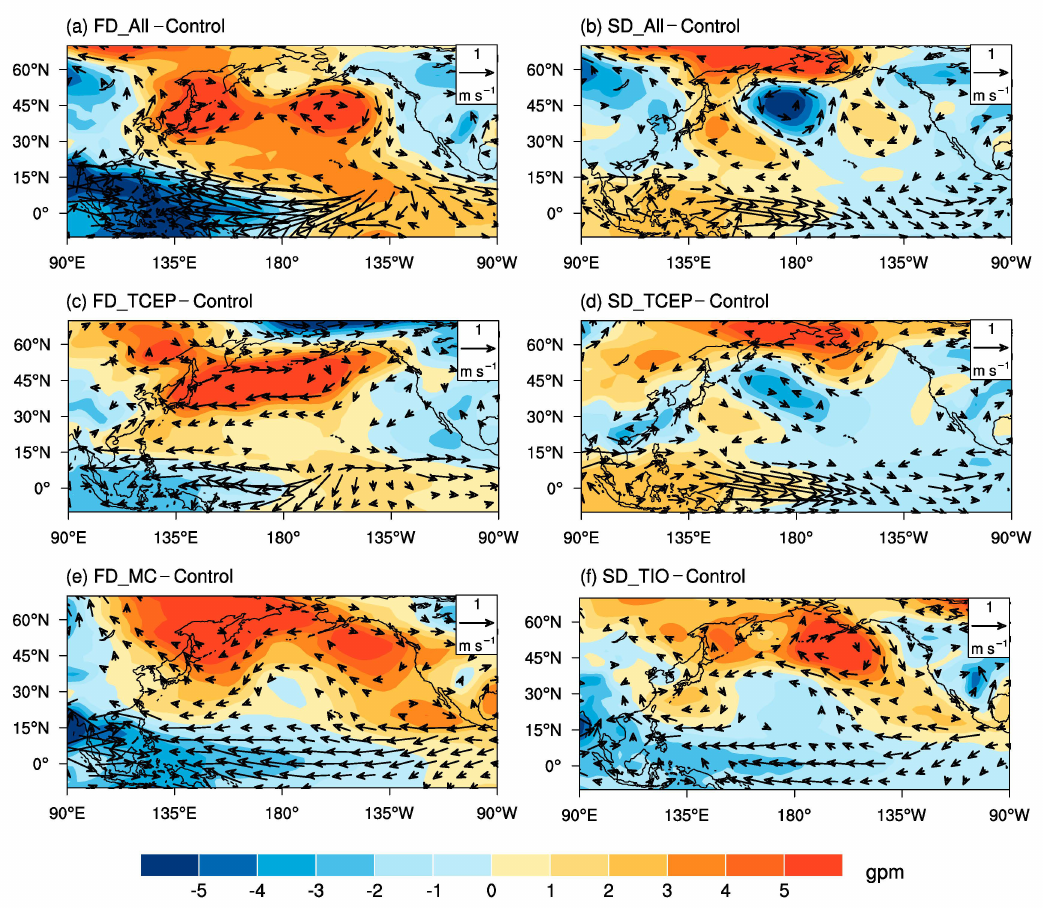
Figure 5. Difference of 850 hPa winds (vectors) and geopotential height (shading) in JJA(1) between ( a ) FD_All run, ( b ) SD_All run, ( c ) FD_TCEP run, ( d ) SD_TCEP run, ( e ) FD_MC run, and ( f ) SD_TIO run, respectively, and Control